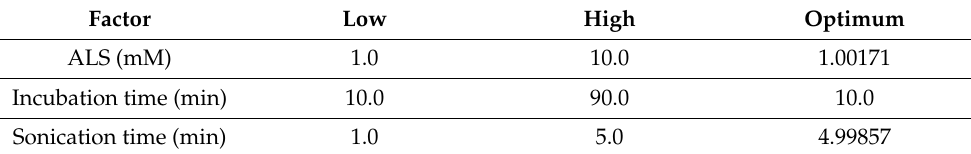
Table 3. Optimum formula for the APA-ALS-NC